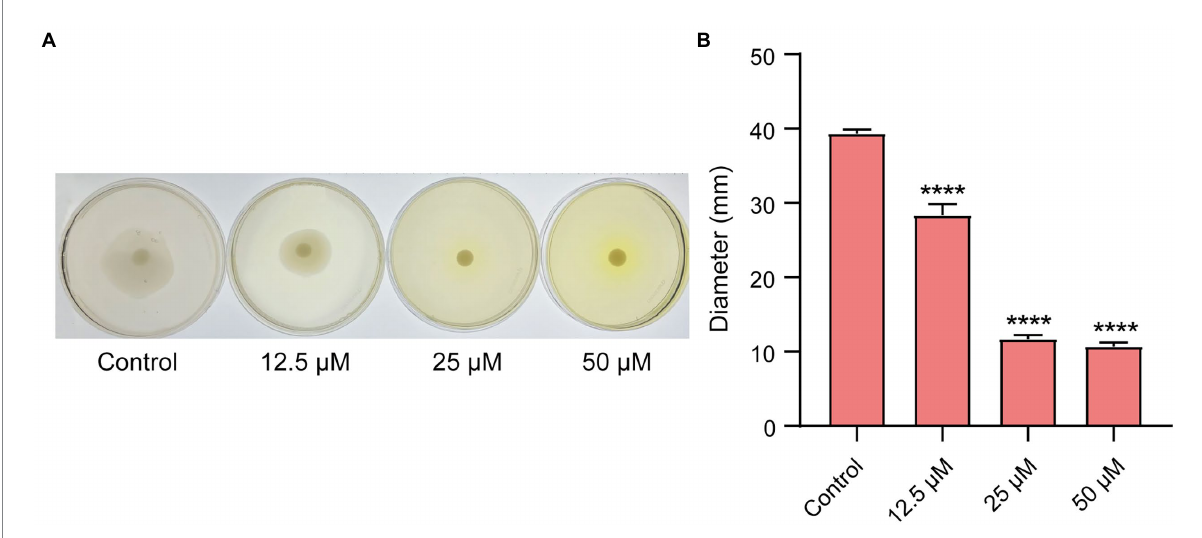
FIGURE 6 Motility inhibition of E. coli with Ech. (A) Images of motility following incubation with E. coli at the various concentration of Ech (0, 12.5, 25, and 50 μ M). (B) Quantitative estimation of motility based on the halo zone’s diameter. **** = p < 0.0001.